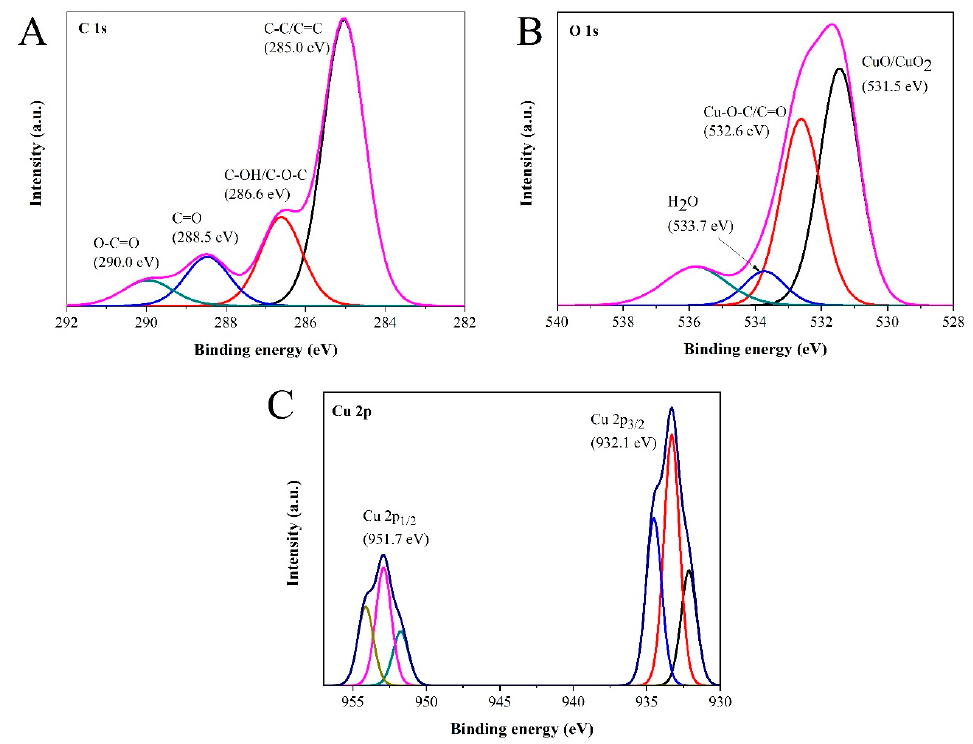
Figure 3. The high-resolution core-level X-ray photoelectron spectroscopy spectra of C 1s ( A ), O 1s ( B ), and Cu 2p ( C ).